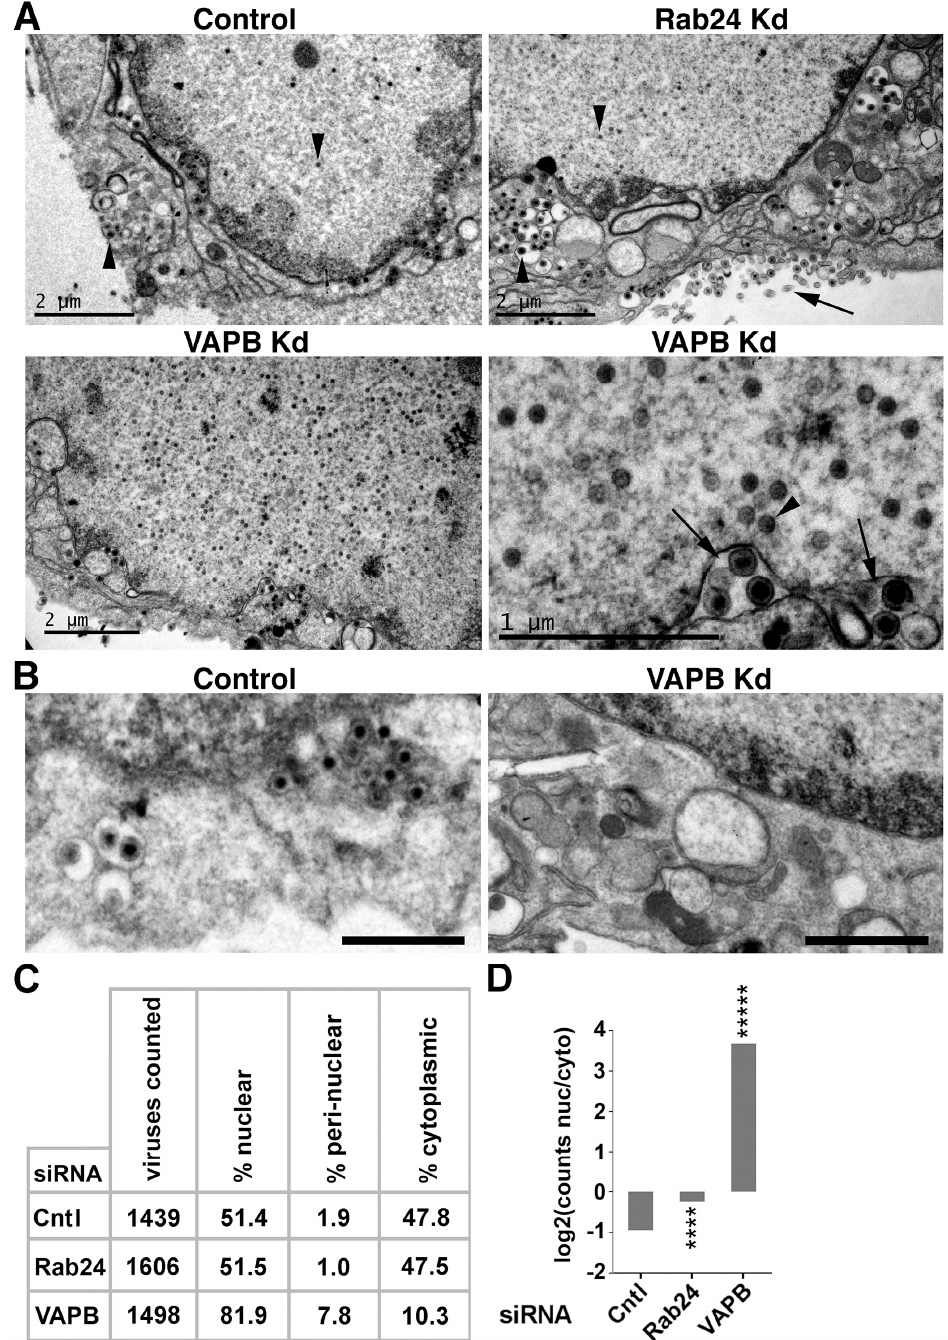
Figure 5. Electron microscopy reveals accumulation of virus particles in the nucleus and their relative absence from the cytoplasm with VAPB knockdown. In all images, the nucleus is at the top of the panel. ( A ) In control and Rab24 knockdown cells, some non ‐ enveloped virus particles could be observed in the nucleoplasm (one example shown for each upper image with downward facing arrowheads), but many enveloped and non ‐ enveloped particles could also be observed in the cytoplasm (one example shown for each upper image with upward facing arrowheads) as well as